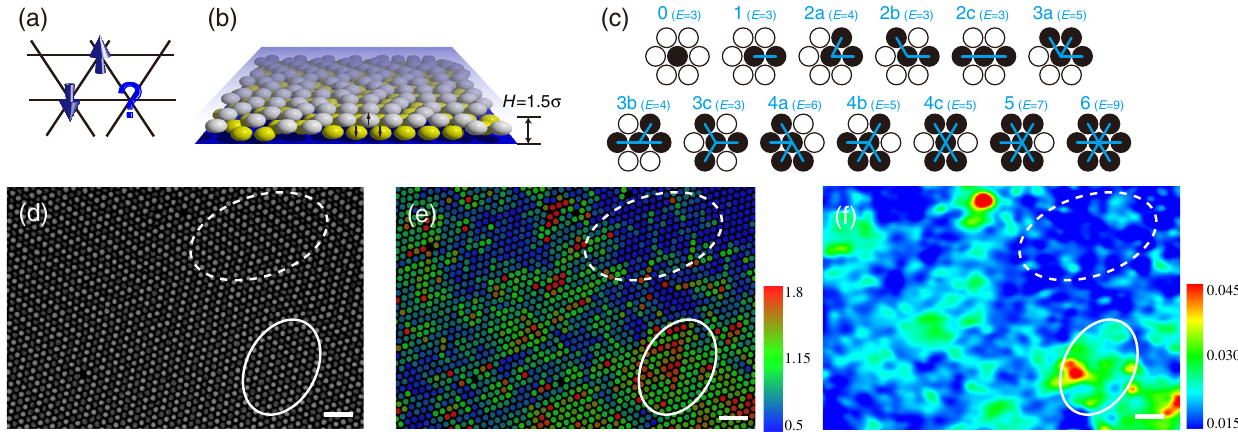
FIG. 1. Correlations among structures, soft vibrational modes, and dynamics in the buckled attractive colloidal crystal. The simulation counterpart is Fig. S4 of SM [14]. (a) Three spins on a triangular plaquette cannot simultaneously satisfy all antiferromagnetic interactions. (b) Schematic of the 1.5-layer colloid confined between two walls with spheres buckled up (white) and down (yellow). (c) All 13 possible local spin configurations, i.e., motifs, labeled with the number of frustrated bonds (blue lines) attached to the central spin. The motif ’ s energy E is the number of frustrated bonds. The weight of a bond at the edge is 1 = 2 because it is shared between two motifs; hence, E ¼ 6 = 2 for motif 0, E ¼ 1 þ 4 = 2 for motif 1, and so on. Panels (d) – (f) are the same sample region. Scale bar: 10 μ m. (d) The raw image with bright spheres buckled up and dark spheres buckled down. (e) The color-coded mean-square displacement (MSD) of each particle normalized by the ensemble-averaged value. (f) The color-coded total magnitude of soft low-frequency modes whose participation ratio p < 0 . 2 [15]. The dashed ellipses mark an ordered region in (d) which has weak motions in (e) and fewer soft modes in (f); the solid-line ellipses mark a disordered region in (d) which has stronger motions in (e) and more soft modes in